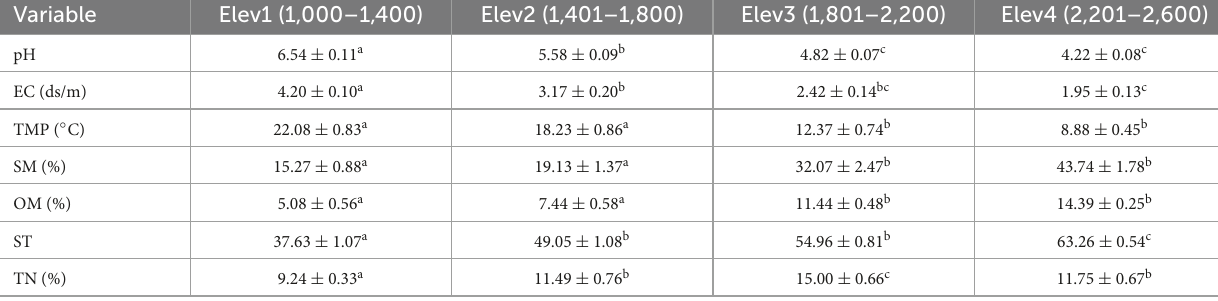
TABLE 1 Soil physico-chemical properties along the elevational gradient in the Trikuta